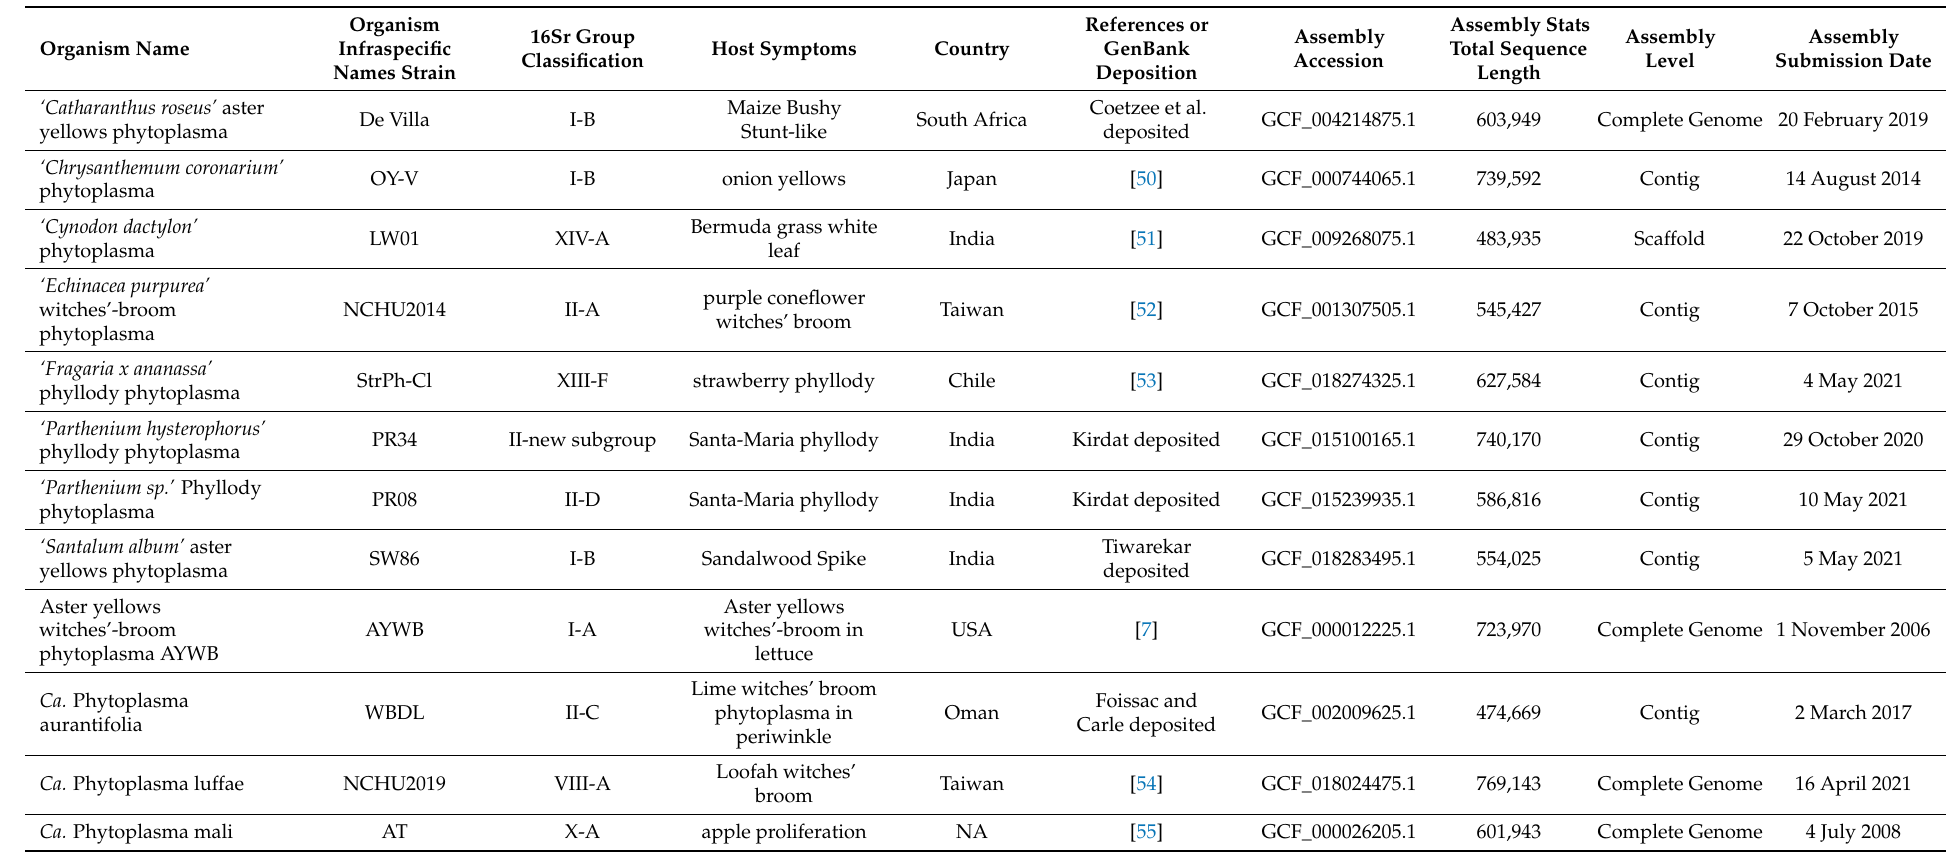
Table 1. A list of complete or draft phytoplasma